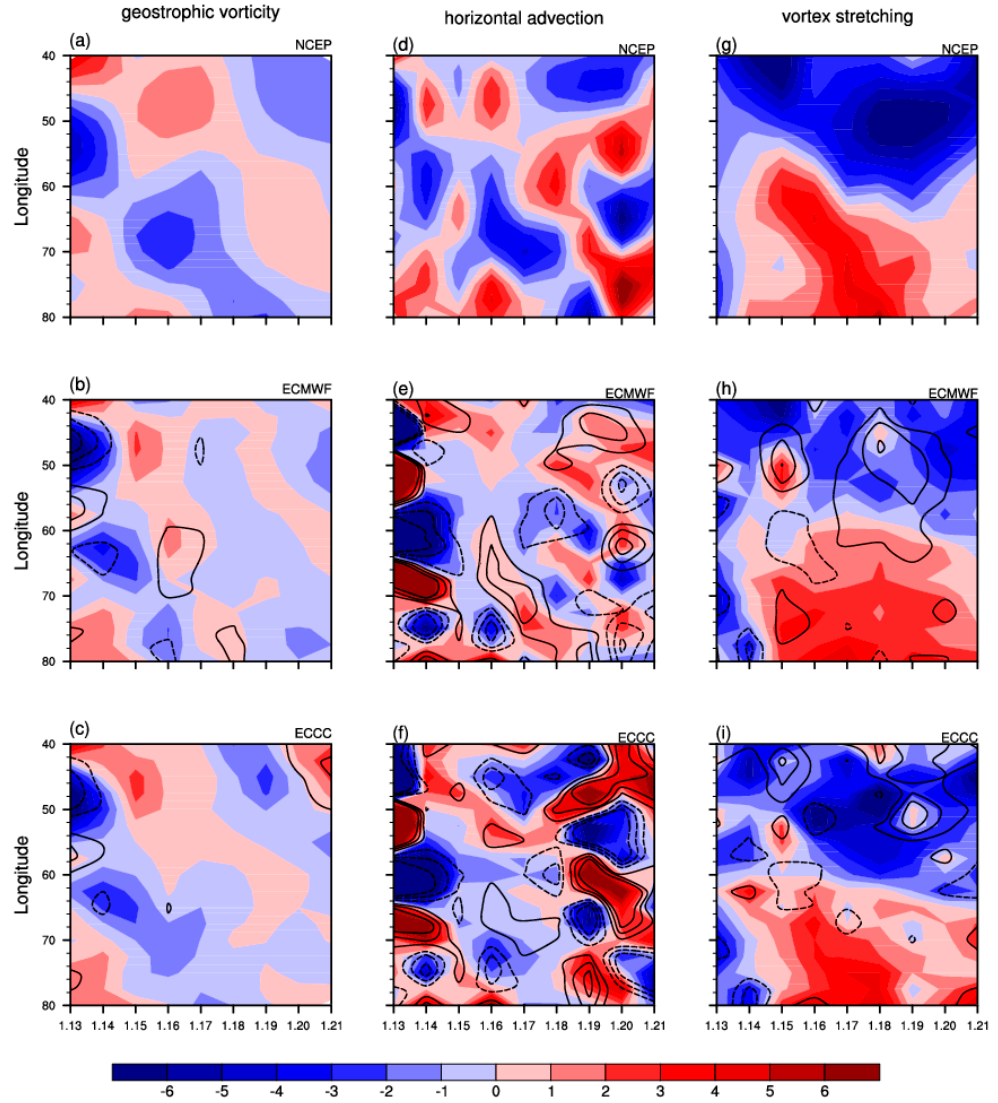
Figure 5. Time-longitude cross-sections of the three terms in the geostrophic vorticity tendency equation (shaded; 1 × 10 − 10 s − 2 ) averaged over the latitudes 50–65 ◦ N from 13 to 21 January 2012, ( a – c ) the tendency of geostrophic vorticity, ( d – f ) the horizontal advection of the absolute vorticity, ( g – i ) the vortex stretching. (top) The observations, (middle) the ECMWF predictions initialized on 12 January, and (bottom) the ECCC predictions initialized on 12 January. The contours represent di ff erences between the models predictions and the observations (contour interval: 2 × 10 − 10 s − 2 ). Negative values are represented by dashed contours, while positive values are represented by solid contours, and the zero contours are omitted.